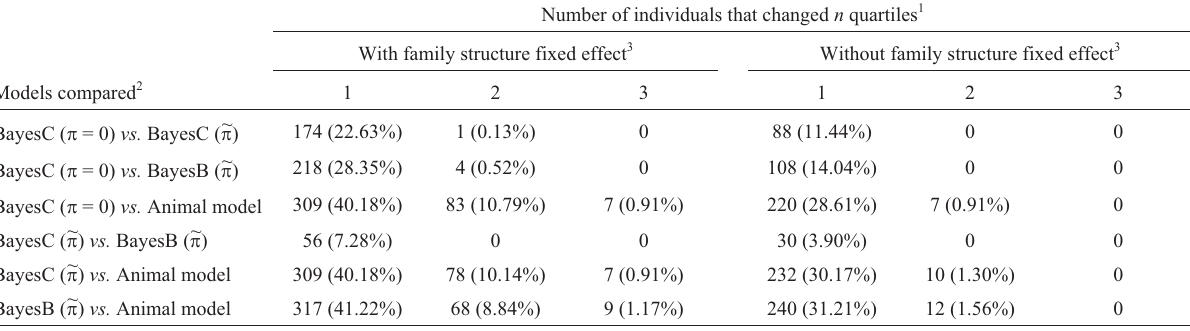
Table 3 - Comparison of the number and percentage of individuals with estimated breeding values for overall temperament at weaning that changed n quartiles between any two